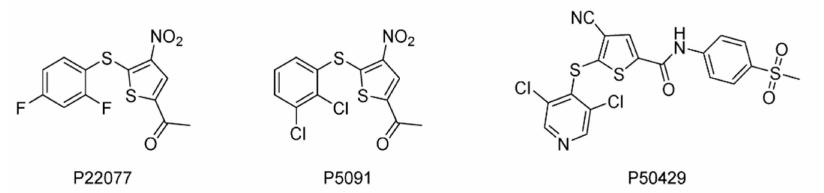
Figure 18. Structures of reported USP7/47 inhibitors.